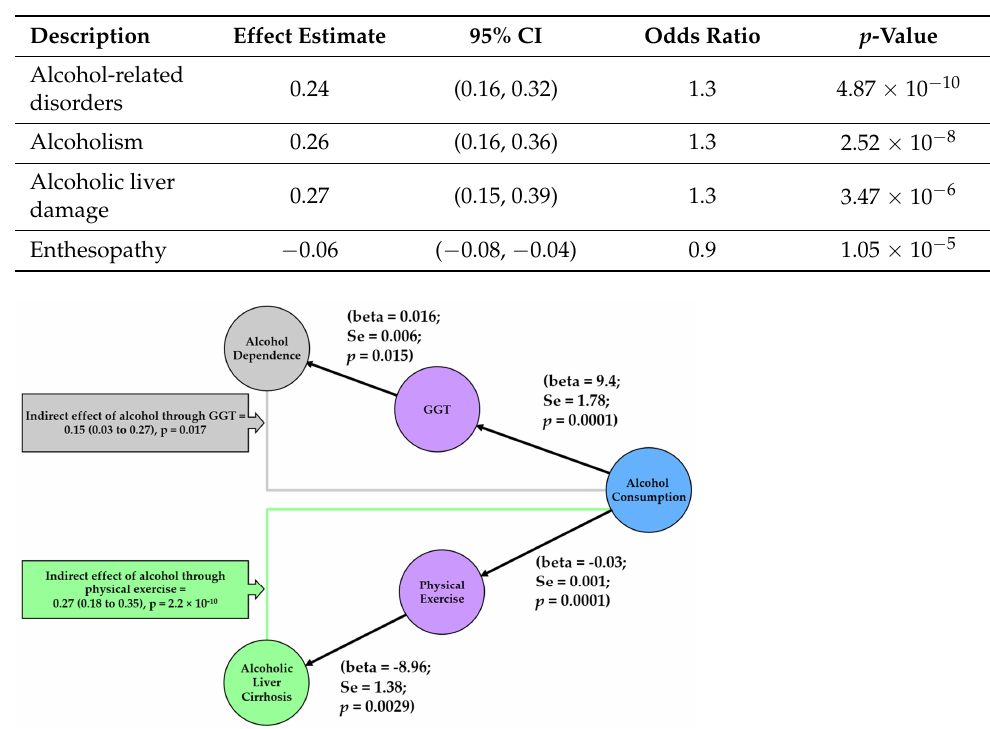
Table 3. Overview of the rs1229984 PheWAS results in the UK biobank cohort.